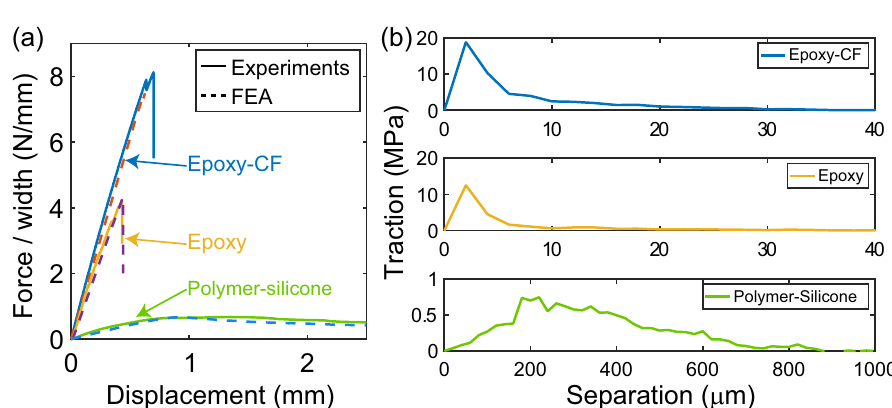
Figure 3. DCB experimental data for ML model validation. ( a ) Experimental F–D curves and FEA results using ( b ) T–S relations trained from experimental F–D curves for epoxy, epoxy-CF, and polymer-silicone